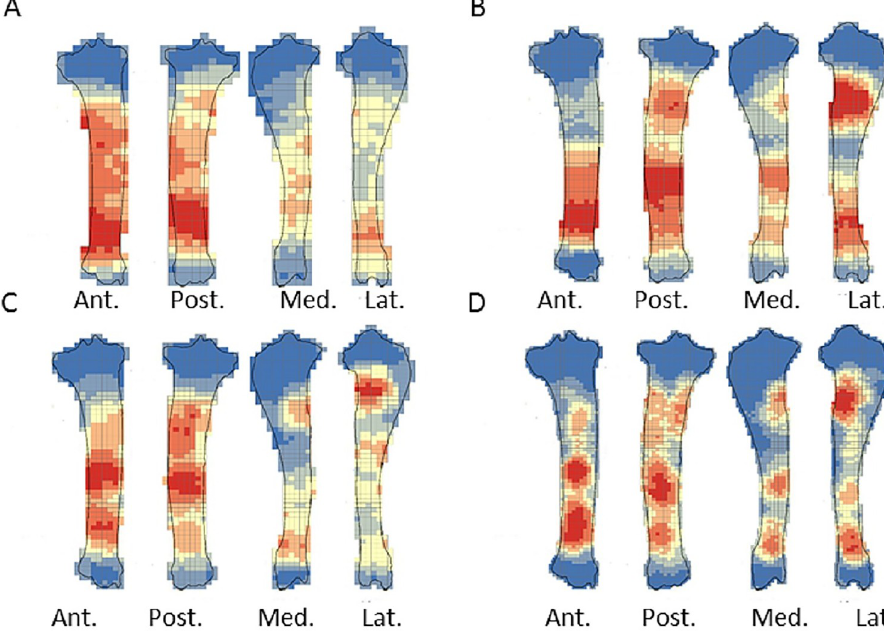
Fig 11. Optimized hot spot analysis of combined percussion marks from the tibias in each series. A- Individual n˚ 4; B- individual n˚6; C- Individual n˚10; D- Merged tibias series(Ind.: Individual).